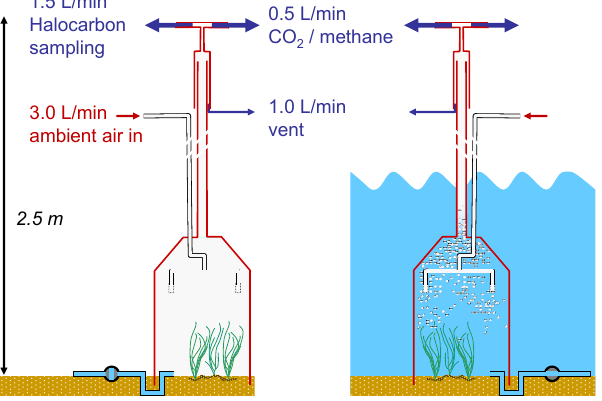
Figure 1. Scheme of the dynamic flux chamber system. During air exposure the chamber acts as a conventional dynamic flux chamber. During tidal immersion the enclosed water is continuously purged with ambient